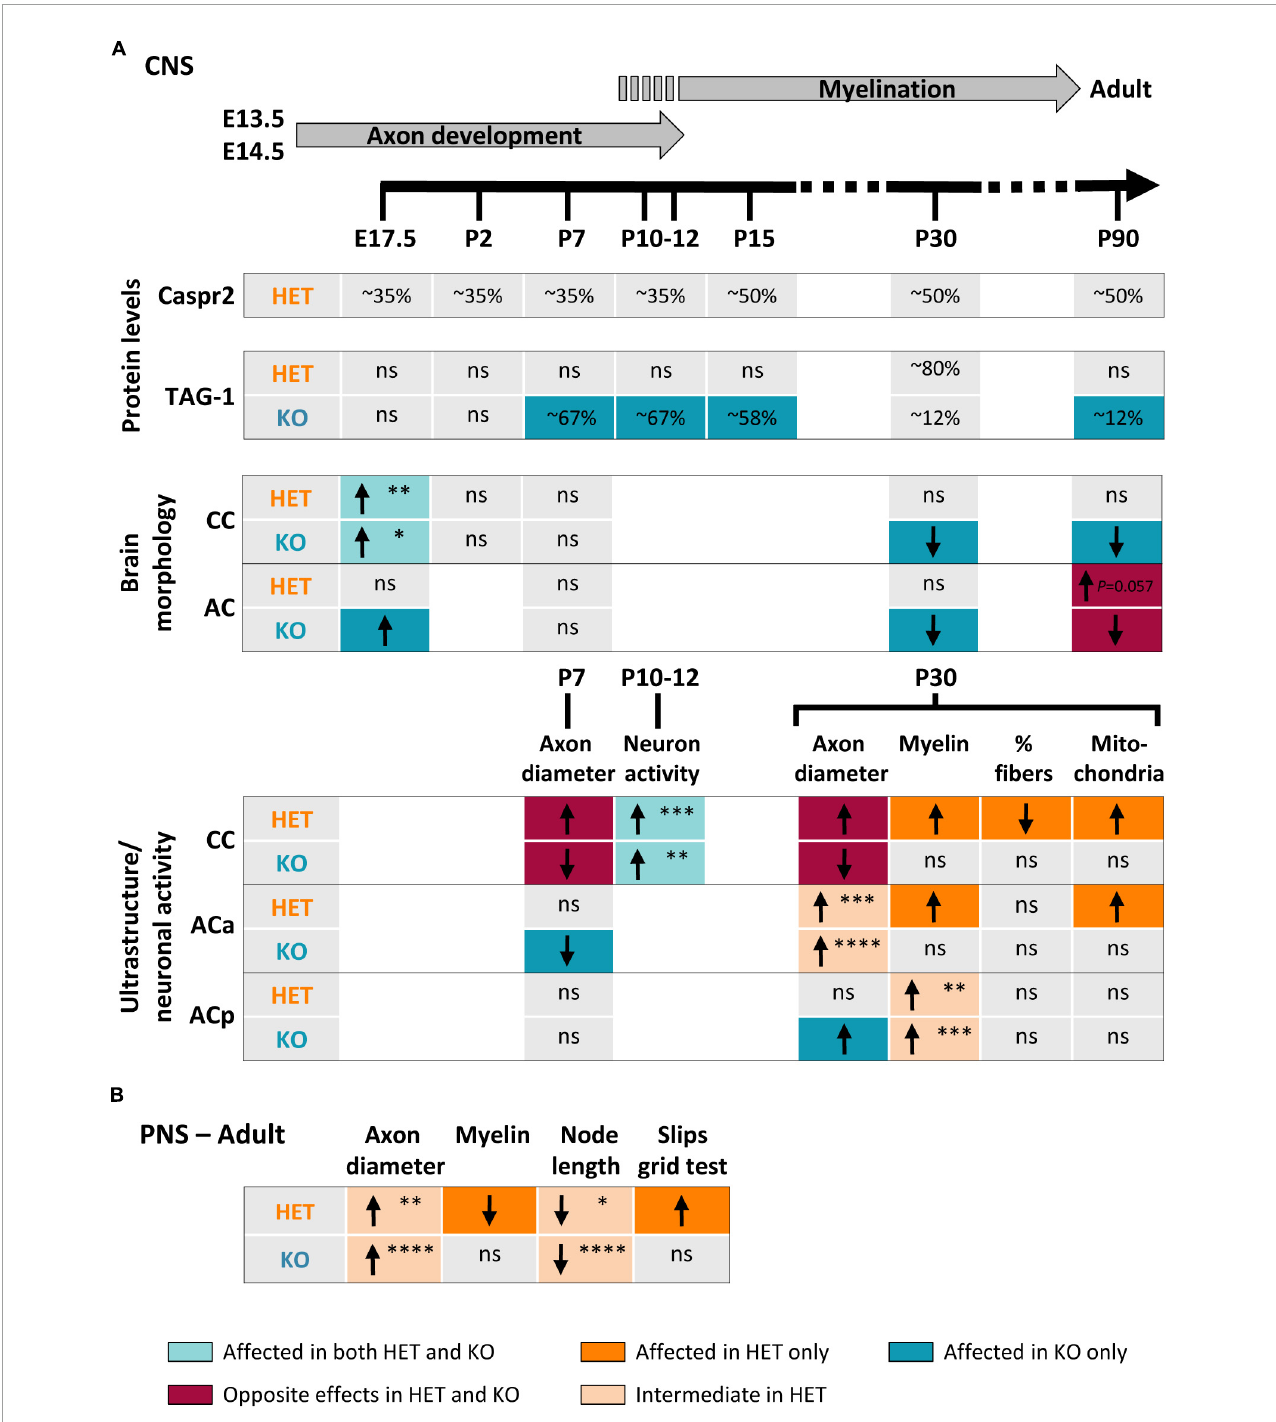
FIGURE10 Summary of changes observed in HET and KO mice as compared to wild-type (WT) mice. Changes observed in the brain during development and in adulthood (A) . Upper part, timeline of axonal development and myelination in mouse. Changes observed in the sciatic nerves and in the grid test performance (B) . Arrows indicate increase ( ↑ ) or decrease ( ↓ ) in the parameters; ns, non-significant changes. The colors of the boxes underline the nature of the differences between HET and KO (color code at the bottom of the figure). The P- values are indicated when HET mice present an intermediate phenotype or tend to be more affected than KO mice ( ∗ P < 0.05, ∗∗ P < 0.01, ∗∗∗ P < 0.001, ∗∗∗∗ P < 0.0001). Corpus callosum (CC) E17.5, P- values for coronal sections; posterior branch (ACp) myelin P30, P- values for